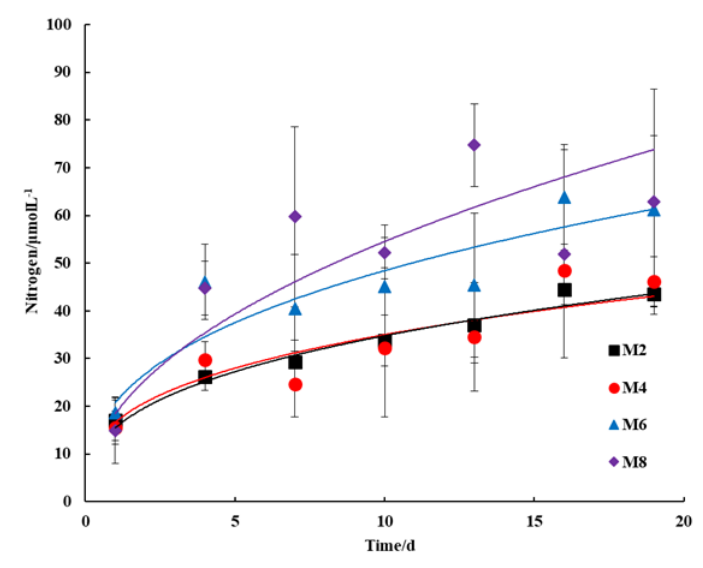
Figure 2. Nitrogen dissolution (M2: y = 16.647 x 0.3229 , R 2 = 0.9777; M4: y = 15.487 x 0.3515 , R 2 = 0.8646; M6: y = 20.766 x 0.3679 , R 2 = 0.8608; M8: y = 18.421 x 0.4714 , R 2 = 0.8207).